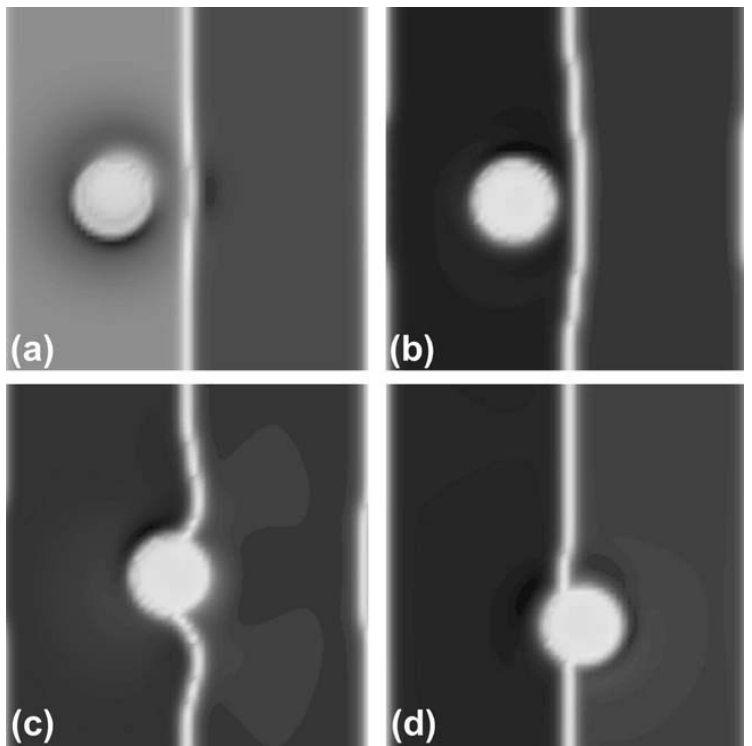
Figure 8. Almost-neutral ( ψ 0 = 0.2, shown in white) particle adsorbing into a binary immiscible mixture for timesteps ( a ) 100, ( b ) 190,000, ( c ) 250,000 and ( d ) 500,000. Reprinted with permissions from Ref. [143], Copyright 2011 Wiley